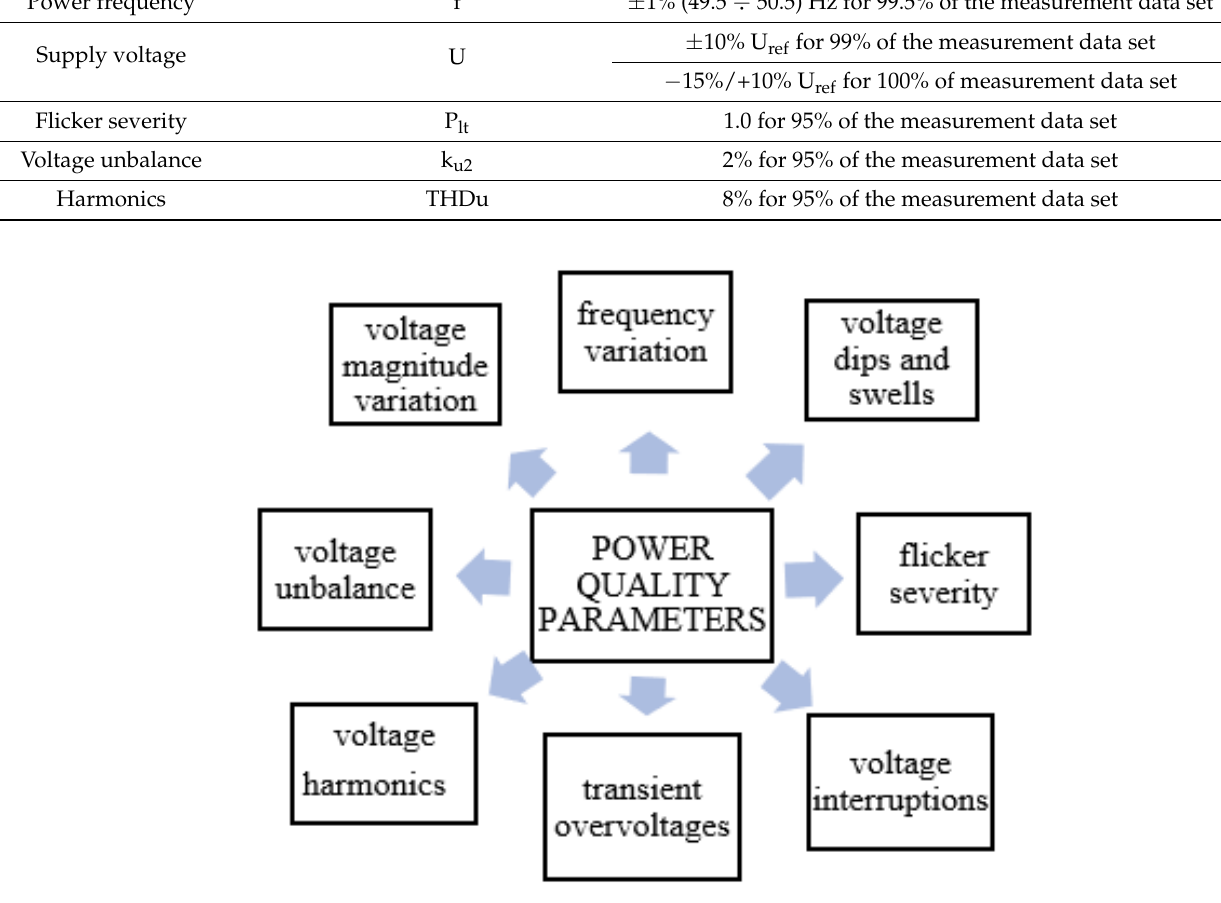
Figure 3. Power quality parameters [66].